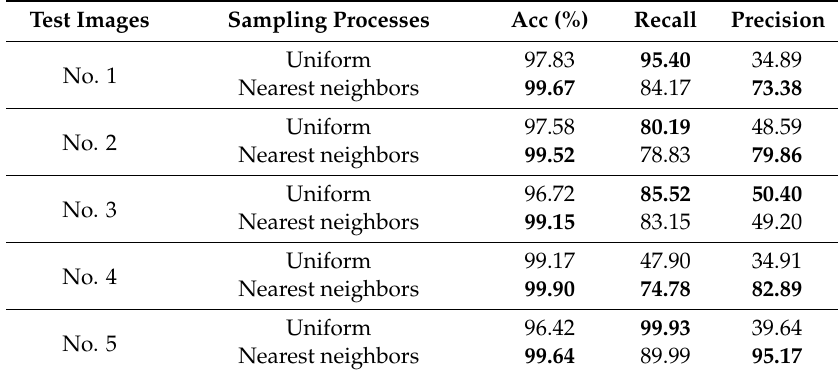
Figure 7. Illustration of training dataset sampling processes. Table 2. Accuracy of different sampling progress (the best results are marked in bold).